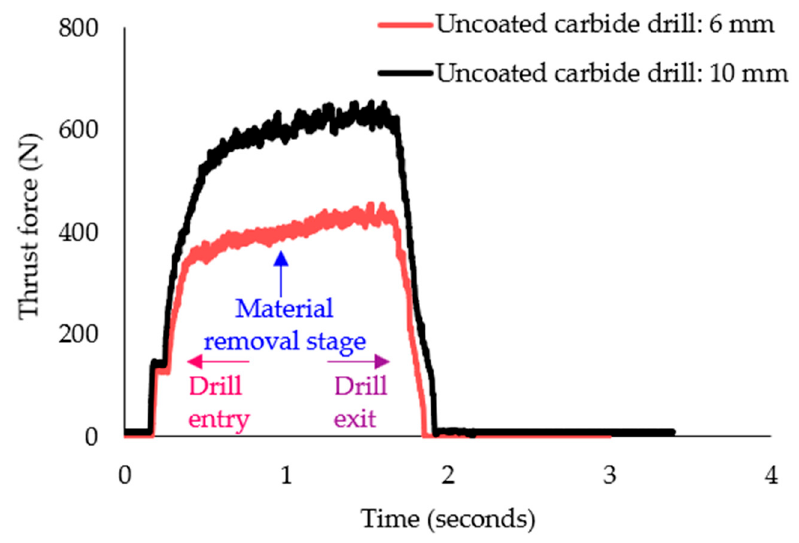
Figure 1. Profiles of average thrust force at 3000 rpm and 0.14 mm/rev.